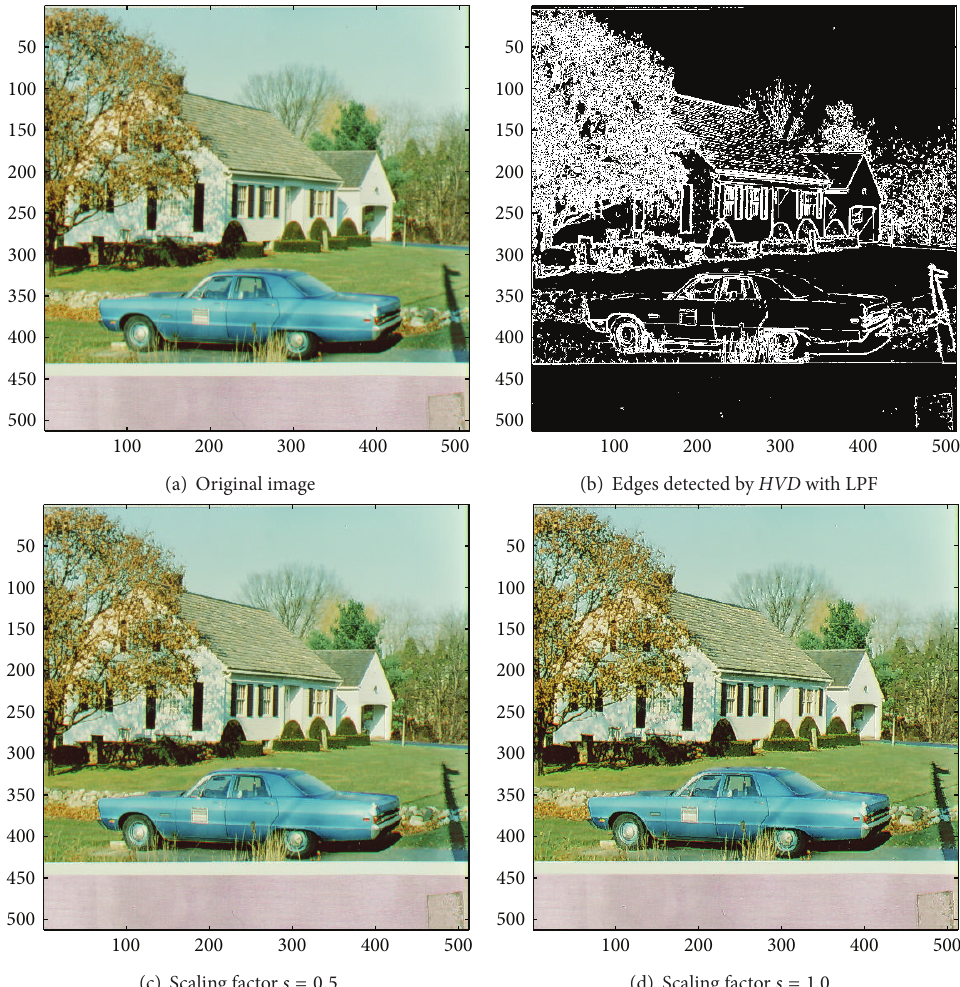
= 13 for HVD . (a) The image “House” (512 × 512 color image). (b) Edges detected by HVD with LPF. (c and d) Sharpened Figure 5: 𝜃 eth results by HVD with scaling factors 0.5 and 1.0 ,